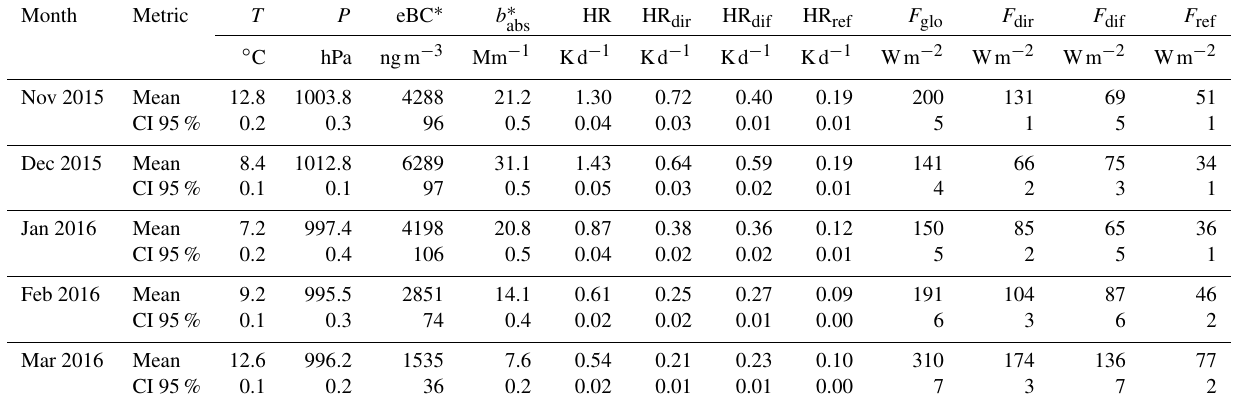
∗ denotes aethalometer data referring to λ = 880 nm